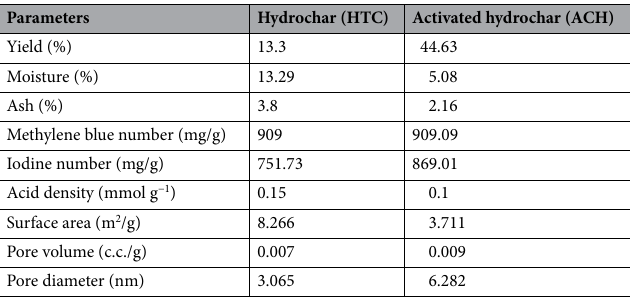
Table 1. Physico-chemical characteristics of the hydrochar and activated